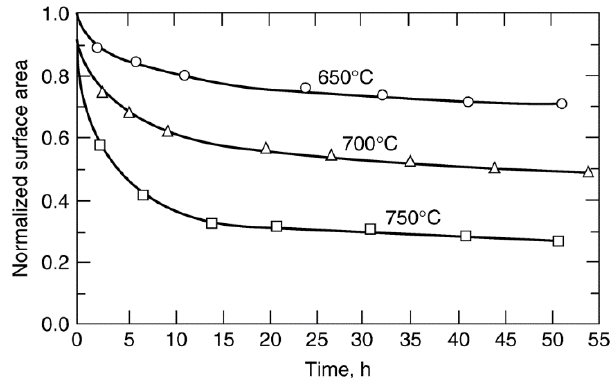
Figure 18. Normalized nickel surface area (based on H 2 adsorption) versus time data during sintering of 13.5% Ni/SiO 2 in H 2 at 650, 700, and 750 °C. Reproduced from [108]. Copyright 1983,